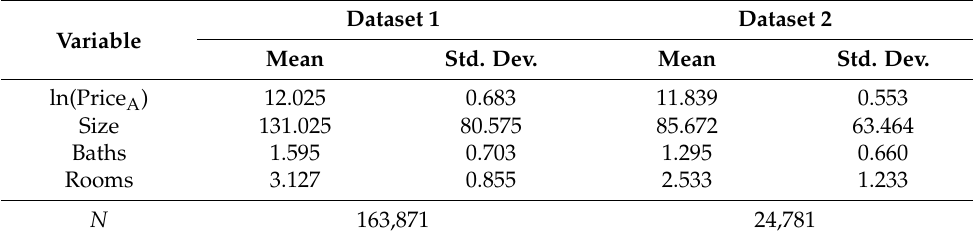
Table 2. Descriptive statistics of the quantitative variables.